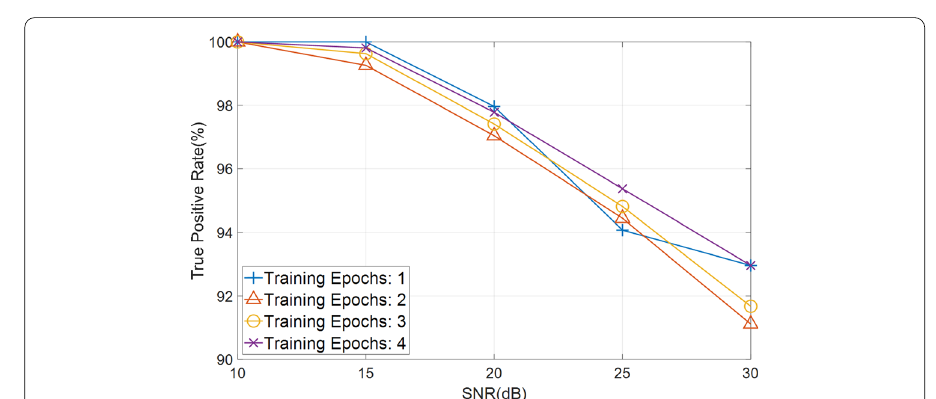
Fig. 23 Relationship between the accuracy of legitimate devices and SNR (True Positive Rate). The relationships between identification accuracy and SNR are shown in this figure when training 5 times for legitimate